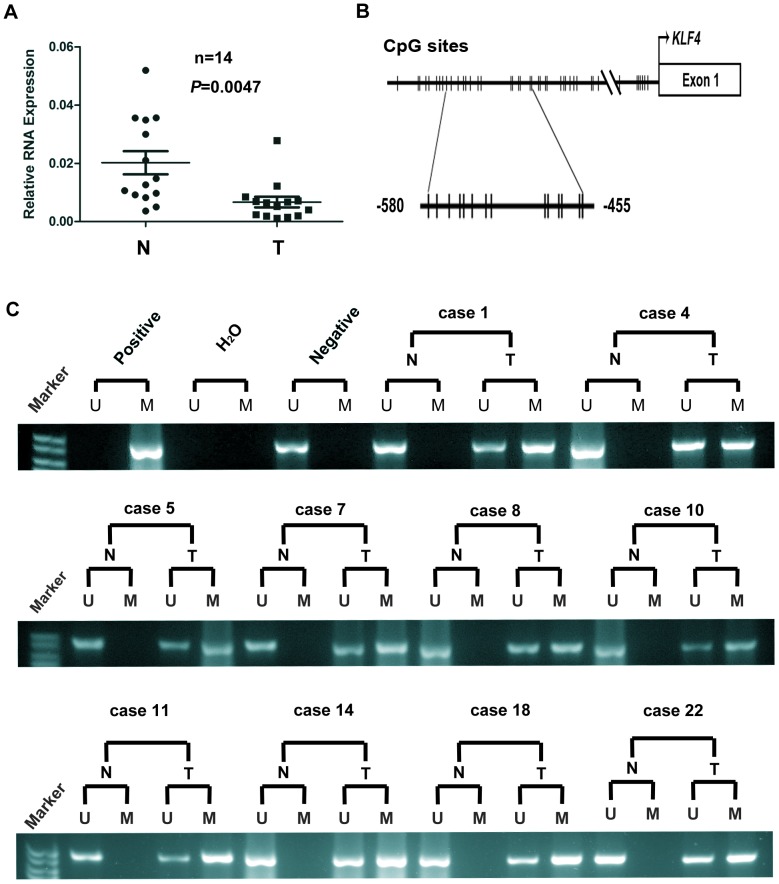
KLF4 was frequently methylated in human primary ccRCC.(A) KLF4 mRNA downregulation in ccRCC tissues. KLF4 expression was quantified by ΔΔCt method, in which PPIA was used as a control sample. N: normal; T: tumor (P<0.01). (B). Schematic structure of the KLF4 promoter CpG island. Analysis of exon 1, CpG, transcription start, and MSP sites. (C) MSP analysis of KLF4 methylation in primary ccRCC tissues and normal tissues. Ten cases with a methylated allele are shown. The methylated allele was observed in 11 of 25 (44%) primary ccRCC tissues but was absent in the corresponding normal tissues. Normal blood lymphocyte DNA (NL), in vitro methylated DNA (IVD), and water were used as the negative control treatment, the positive control, and the blank sample, respectively. N: normal; T: tumor; M: methylated; U: unmethylated.